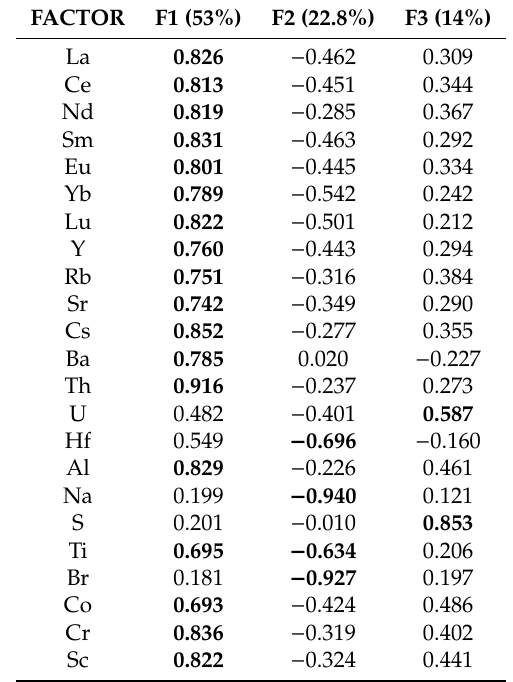
Table 6. Factor analysis: rotated factor loadings (factor scores) of the three main factors. Bold: the most significant elements of each